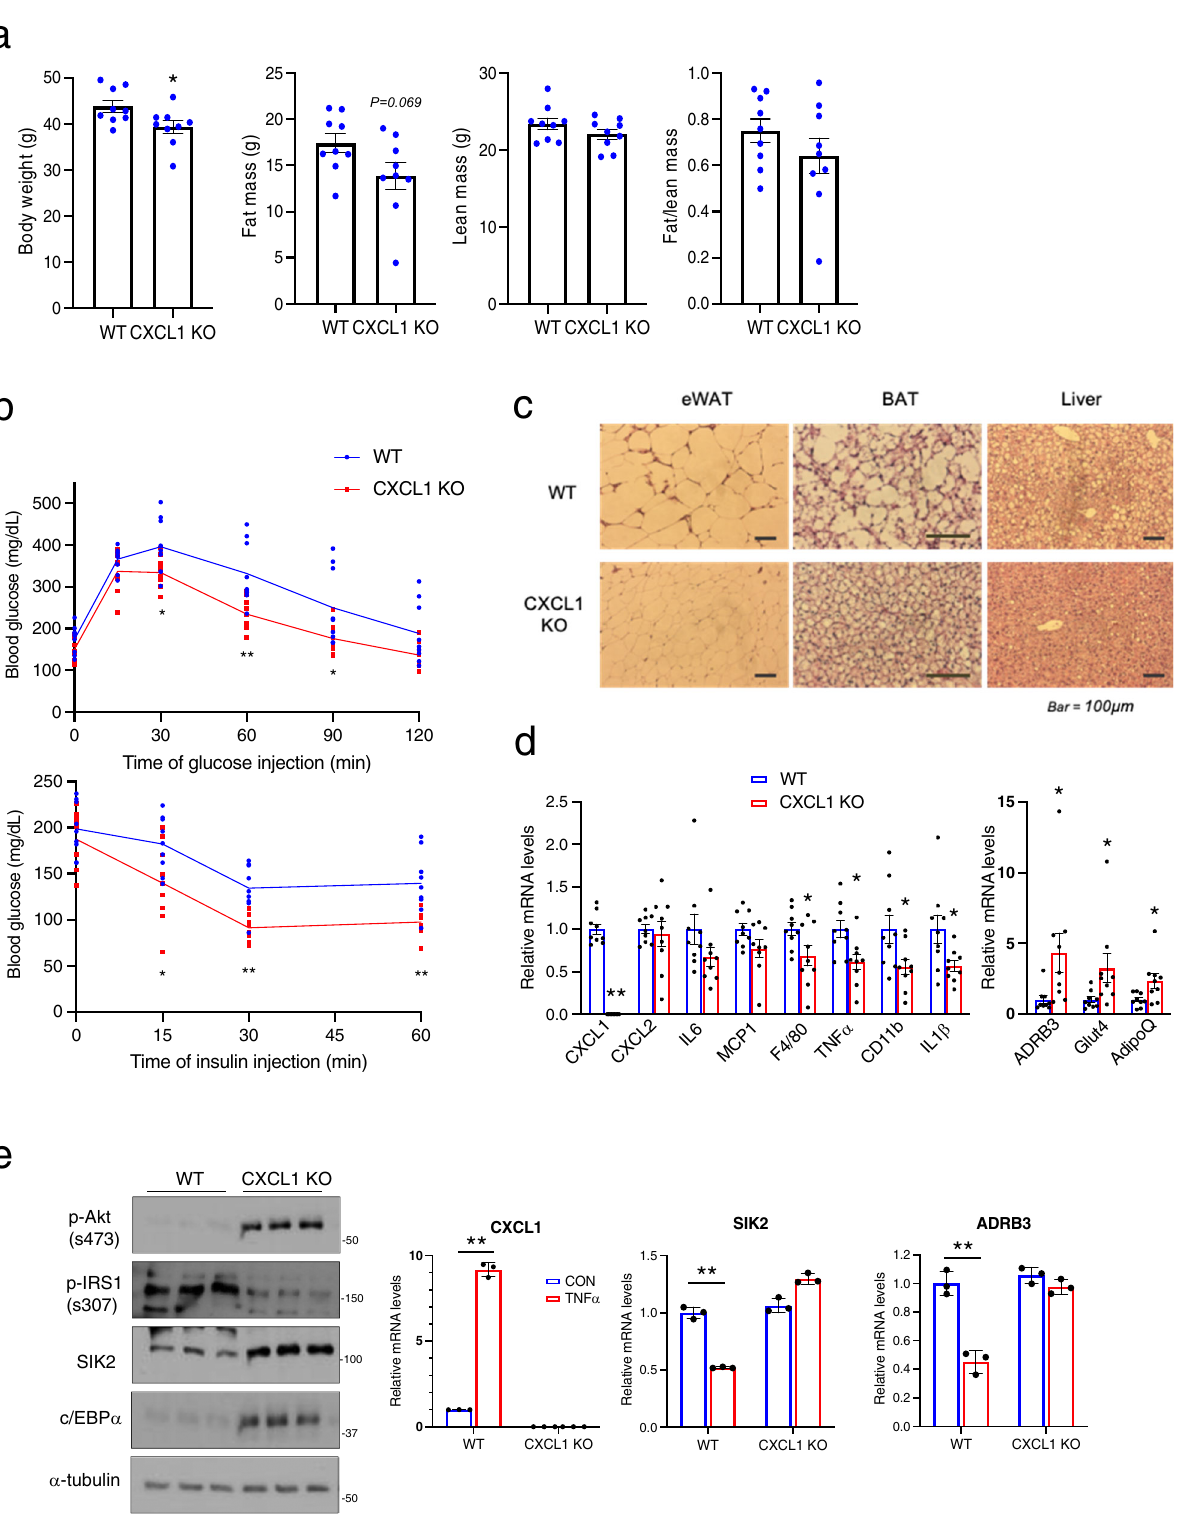
Fig. 6 Knockout of CXCL1 corrects HFD-induced glucose intolerance and metabolic gene expression in WAT. a Body weight and fat mass in CXCL1 KO and WT littermates following HFD feeding for 10 weeks (* P < 0.05, t -test; n = 9, per group). b Glucose tolerance (top, 1 g/kg of glucose) and insulin tolerance (bottom, 1 U/kg of insulin) testing of CXCL1 KO and WT littermates (** P < 0.01, * P < 0.05, t -test; n = 9, per group). Mice were fed a HFD for 10 weeks. c H&E staining of sections from eWAT, BAT, and livers of CXCL1 KO mice and WT littermates. Representative images from more than 5 mice per group. d Relative mRNA amounts for immune-related and metabolic genes by quantitative PCR of eWAT from HFD fed (10 weeks) CXCL1 KO and WT littermates (** P < 0.01, * P < 0.05, t -test; n = 9 per group). e Effect of CXCL1 de fi ciency on insulin signaling in differentiated white adipocytes from CXCL1 KO and WT littermates. Right, qPCR analysis showing effect of CXCL1 depletion on TNF α (10 ng/ml, 6 h) mediated changes in SIK2 and c/EBP α (** P < 0.01, * P < 0.05, one-way ANOVA; n = 3 per group). Data in a , b , and d represent mean ± SEM, and data in e represent mean ±